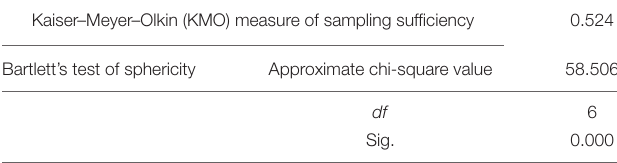
TABLE 12 | KMO test and Bartlett’s test of